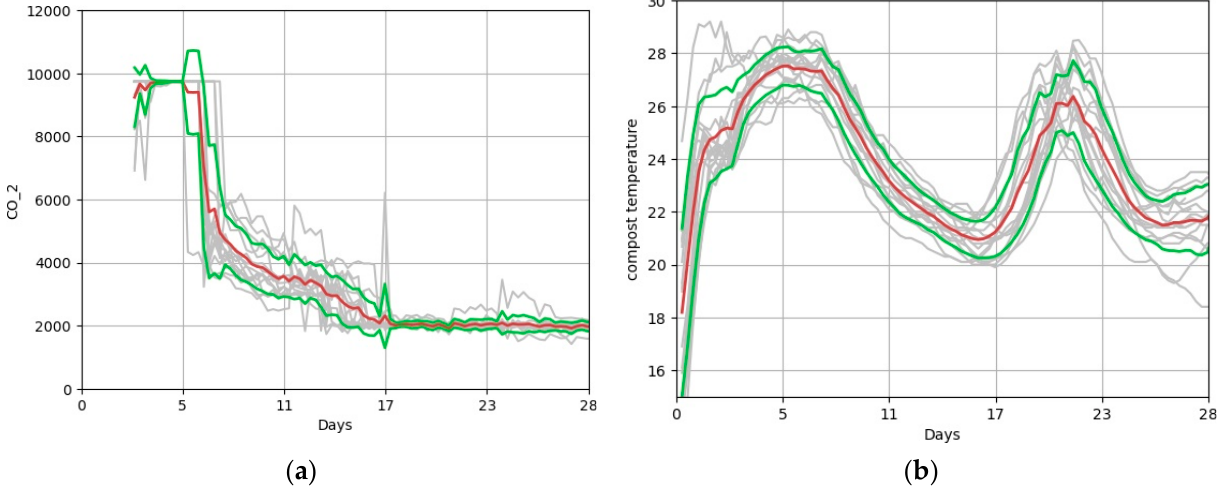
Figure A1. CO 2 ( a ) and compost temperature ( b ) for cultivations used in the training. The brown line represents the medium value, the green line represents standard deviation.